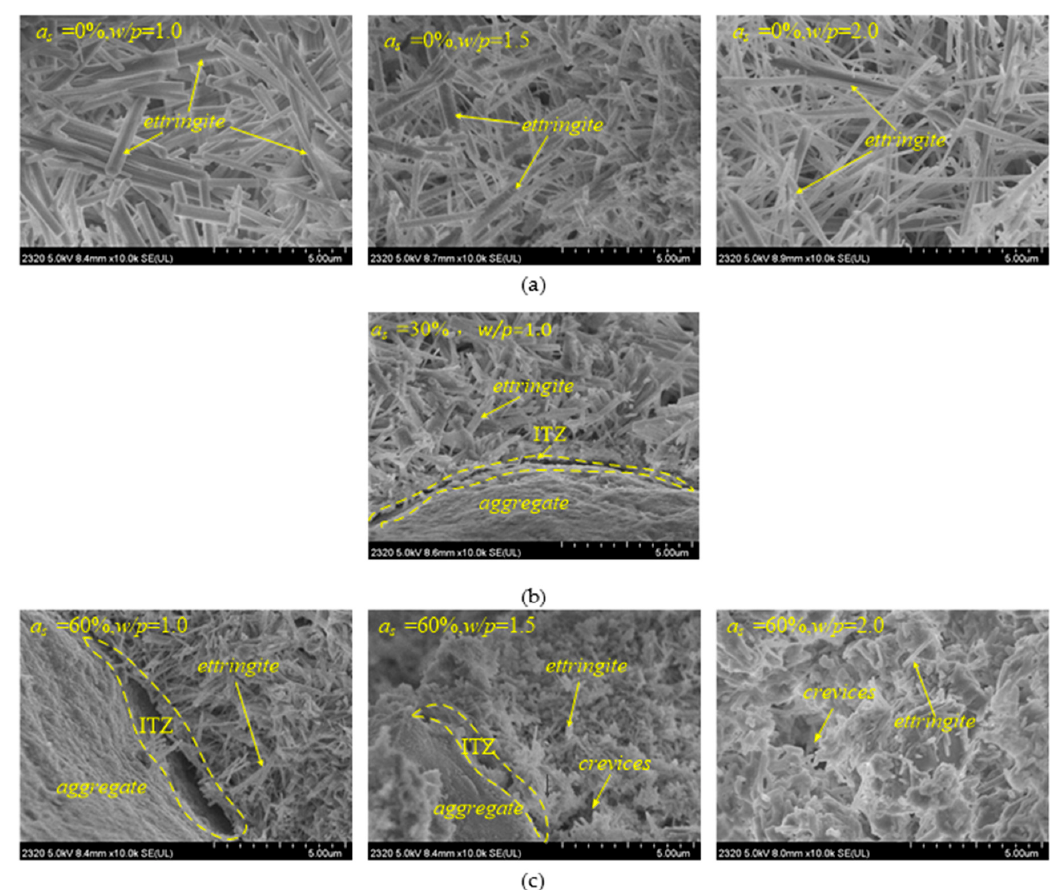
Figure 3. SEM images of SBM specimens: ( a ) Sand content( a s ) = 0% and different water–powder ( w / p ) ratio; ( b ) Sand content( a s ) = 30% and water–powder ( w / p ) ratio = 1.0; ( c ) Sand content( a s ) = 60% and different water–powder ( w / p ) ratio.